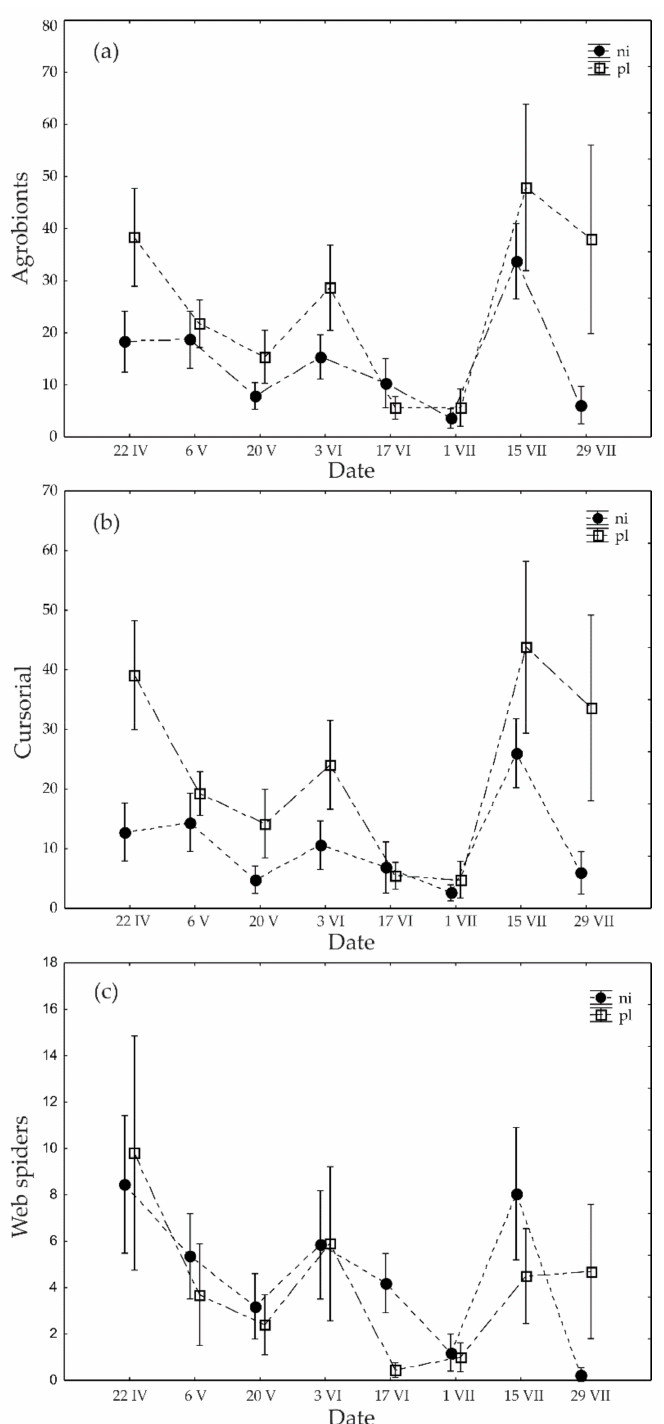
Figure 3. Average abundance of agrobionts ( a ), cursorial ( b ), and web spiders ( c ) in relation to studied soil tillage (ni-non-inversion and pl-ploughed) in cereals fields (vertical lines indicate 0.95 confidence